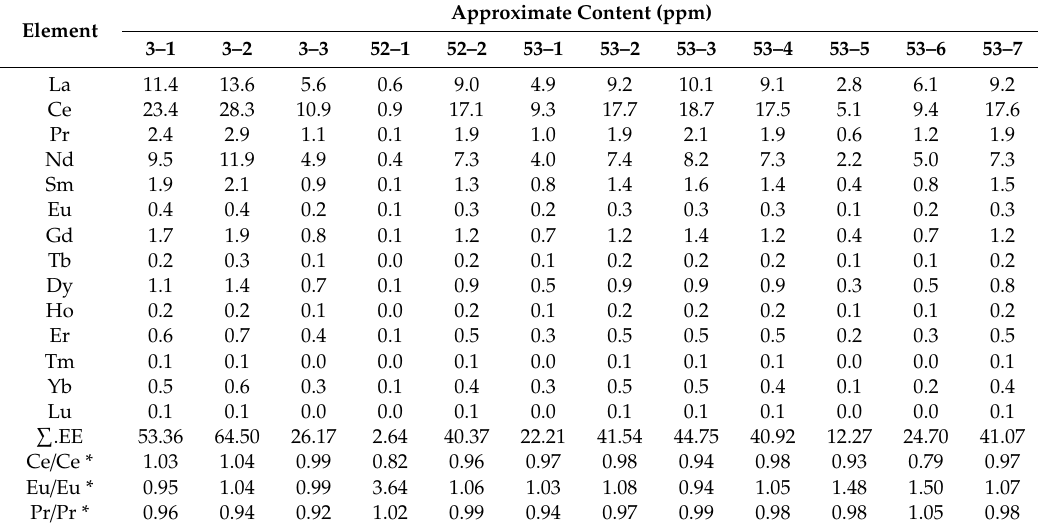
Table 2. Rare earth element (REE) contents of the authigenic